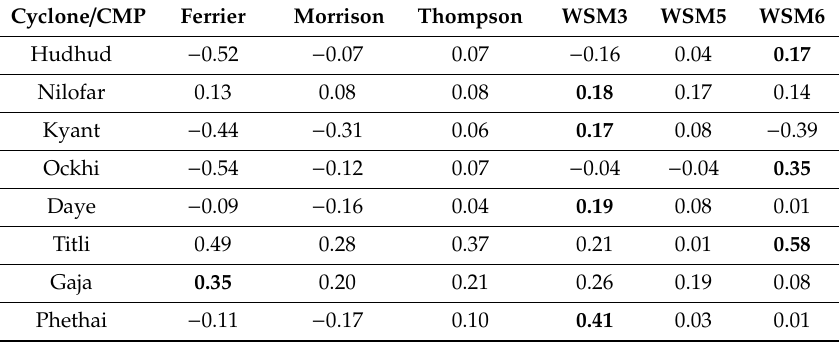
Table 4. Skill score for Direct Positional Error (DPE).